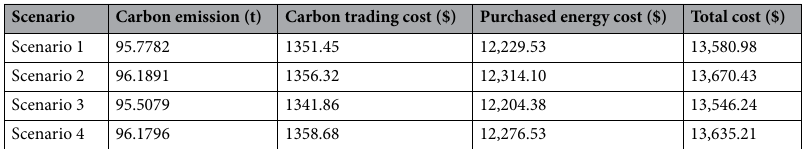
Table 4. Carbon and cost of four scenarios.